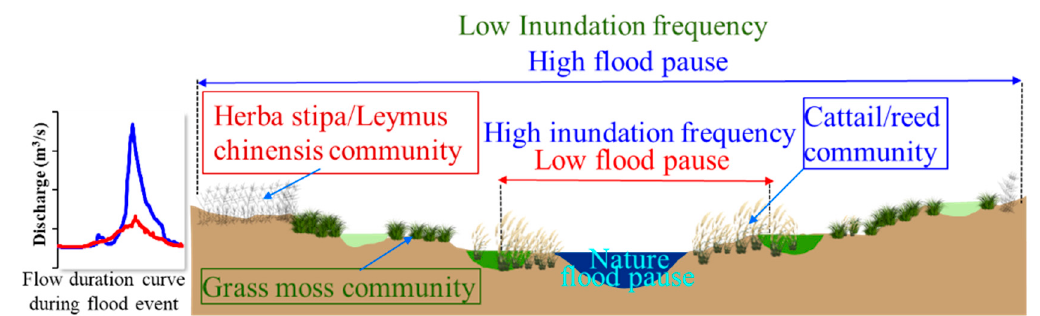
Figure 9. Conceptual representation of high and low inundation frequency areas of wetlands under high and low flood pulse conditions.